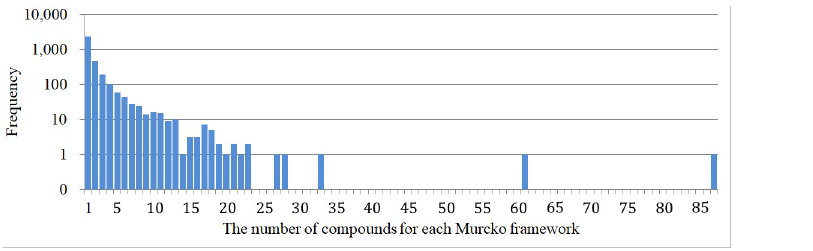
Fig 7. Histogram of the number of compounds in each Murcko frameworks.